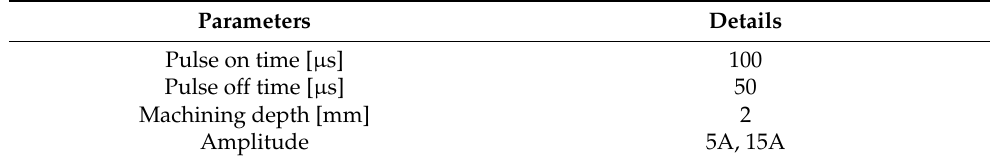
Table 2. Parameters considered during machining. Parameters Details